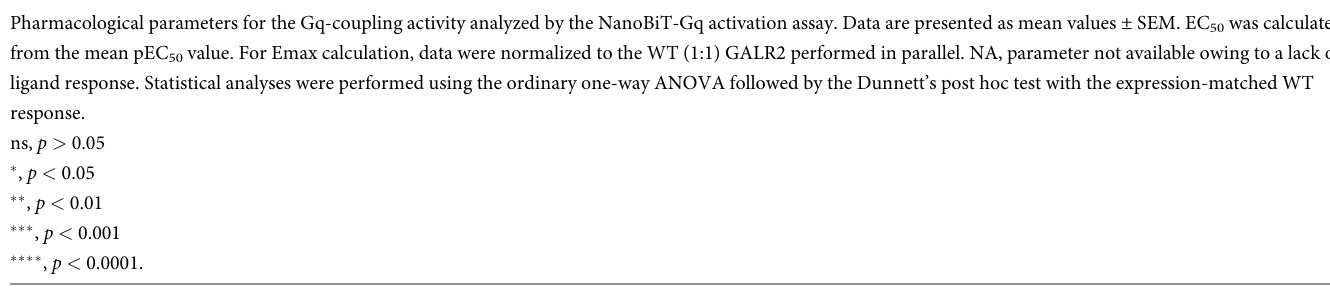
Table 2. Pharmacological parameters of Gq-signaling activity of GALR2 mutants. GALR2 Expression level